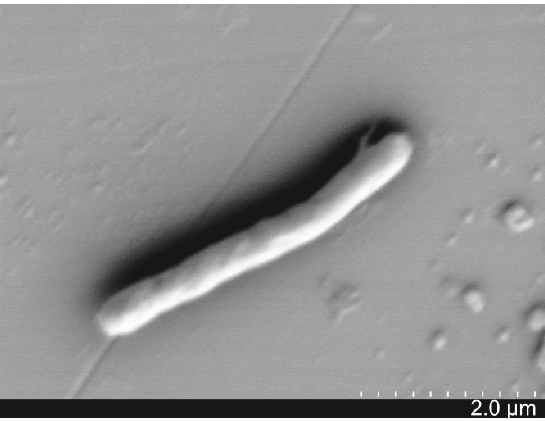
Figure 1. Scanning electron microscopy (SEM) image of morphological characteristics of algicidal bacterium SJ-73.